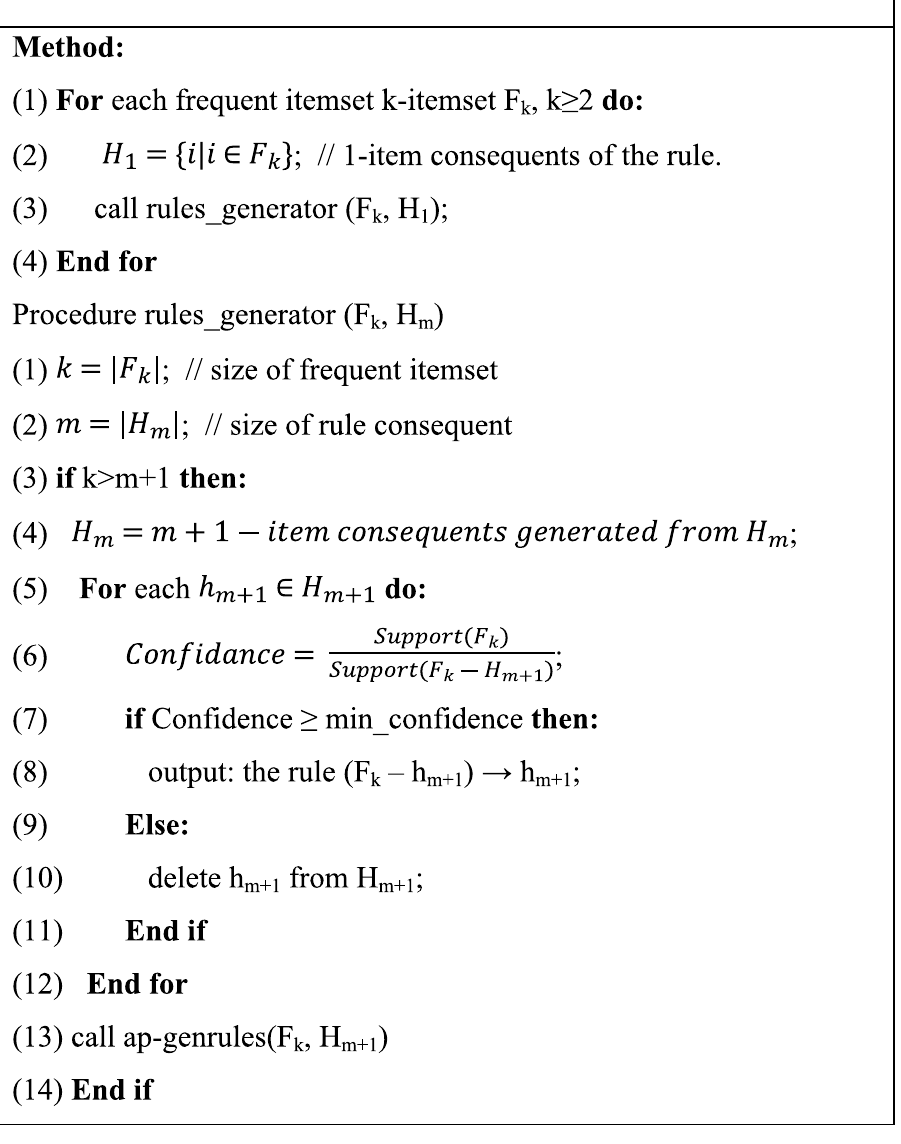
Table 8. Pseudocode of rules generation step in FP-Growth algorithm 72